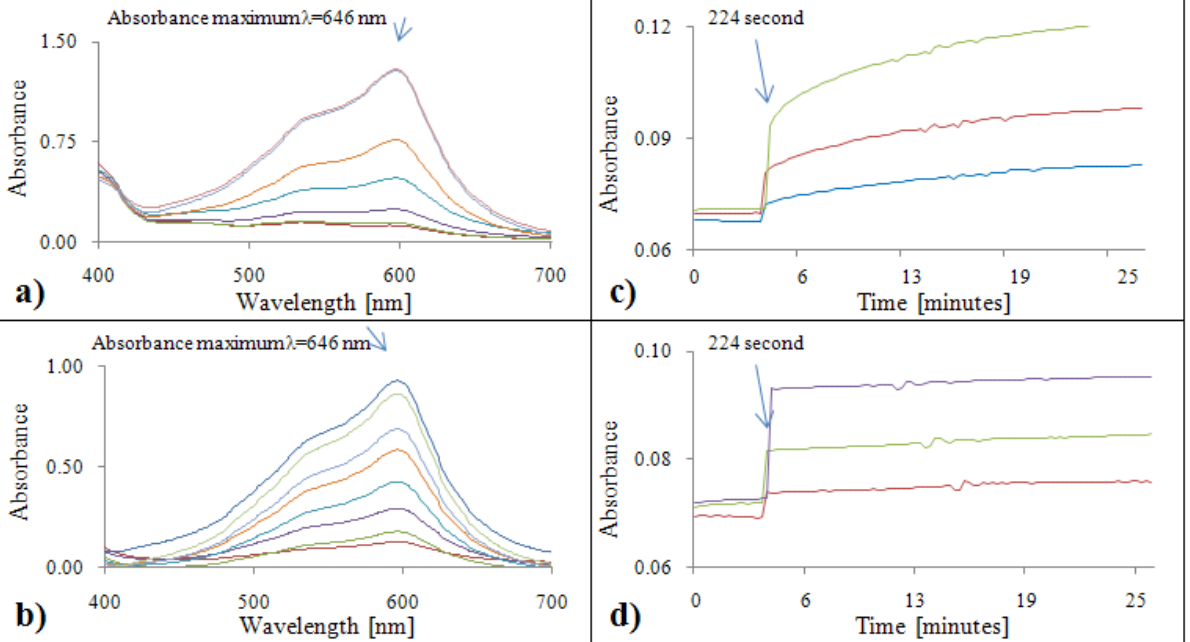
Figure 3. FRAP absorption spectra (450 – 700 nm) for gallic acid (a) and Trolox ® (b) . Dependence of absorbance of FRAP with gallic acid (c) and Trolox ® (d) on time.